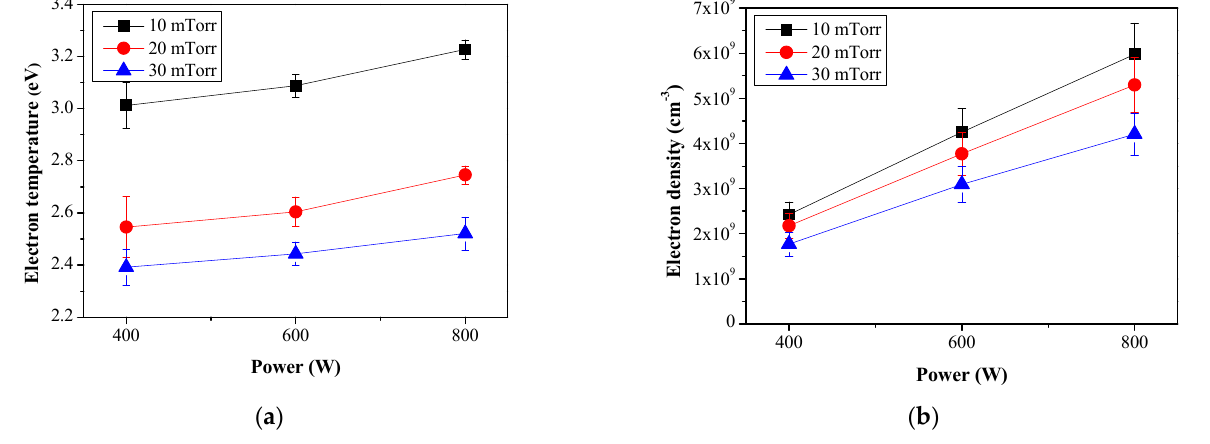
Figure 3. ( a ) Electron temperature dependence on power, ( b ) electron density dependence on power.